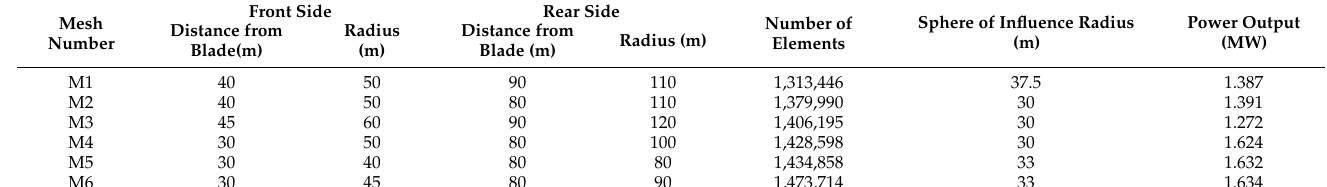
Table 3. Computational domain dimensions, mesh size and estimated power output.